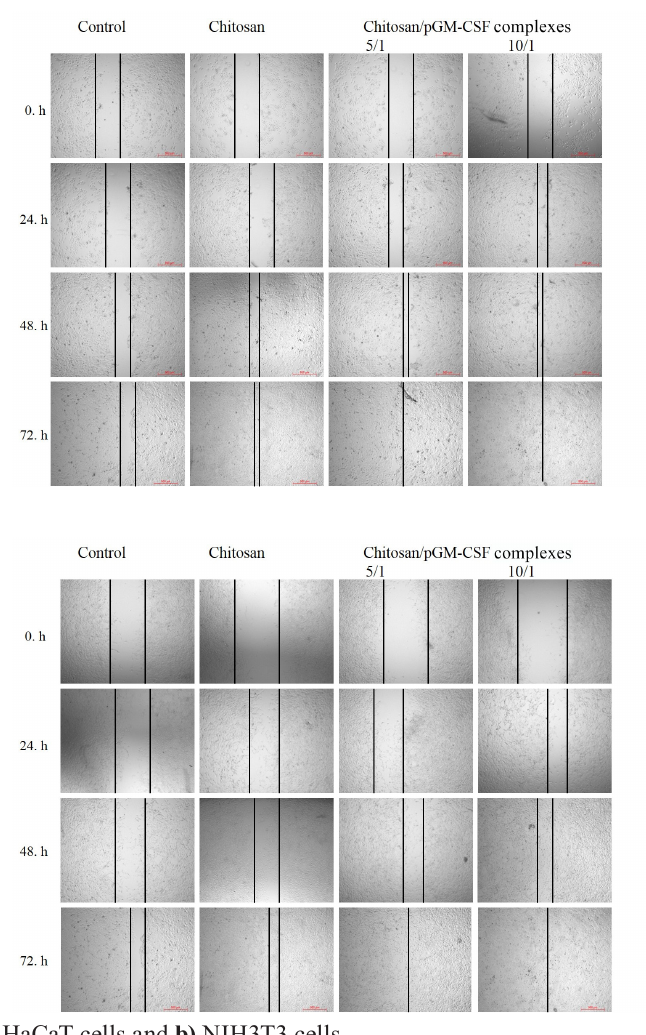
FIGURE 4 - Scratch assay in a) HaCaT cells and b) NIH3T3